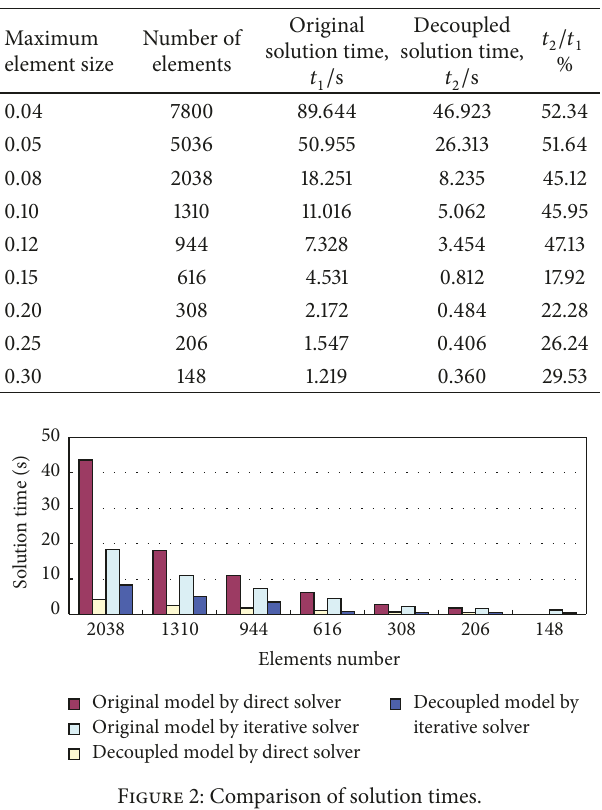
Table 6: Comparison of solution time in 2D model using iterative solver, GMRES.